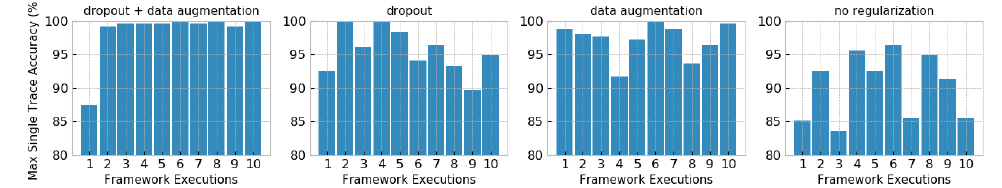
Figure 24: Random CNN hyperparameters: maximum single trace accuracy on the cswap- pointer dataset for ten different framework executions and attacking the sample interval range from 550 to 800 of all